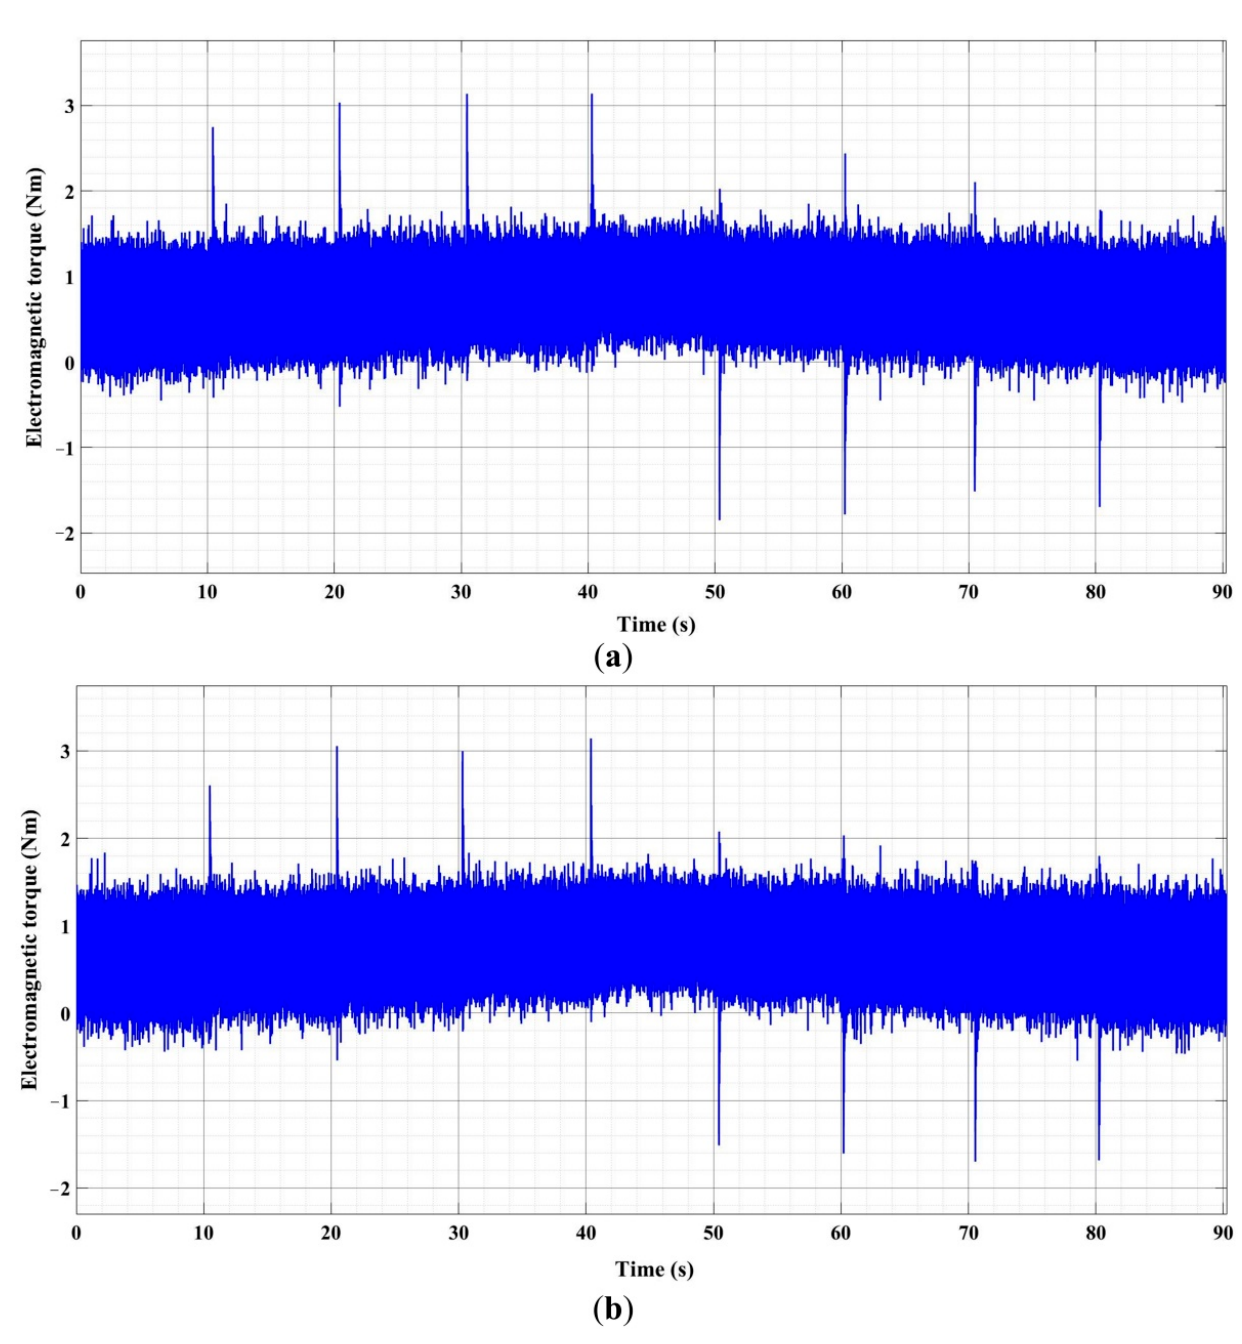
Figure 46. Comparative real-time evolution of the electromagnetic torques: ( a ) with PI-PSO controller; ( b ) with backstepping controller.